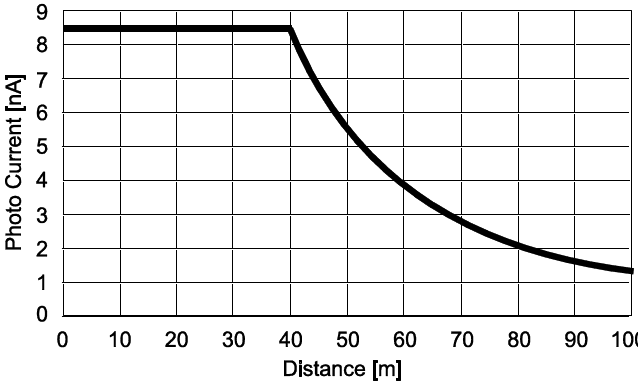
Figure 13. Photo current verses distance (LED Array size: 5 cm × 5 cm, LED: λ = 870 nm, IE = 80 mW/sr, 10 × 10 array, cell size: 7.5  m × 7.5  m, η = 24%@870 nm, Lens: FN = 1.4, TL =